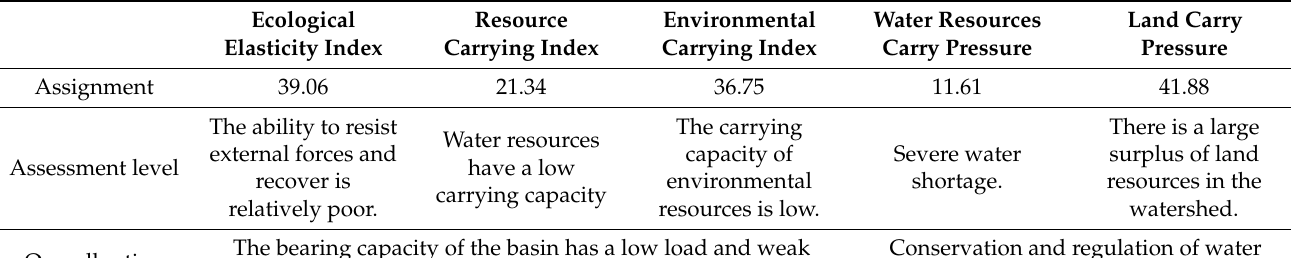
Table 1. Results of ecological assessment of regional water